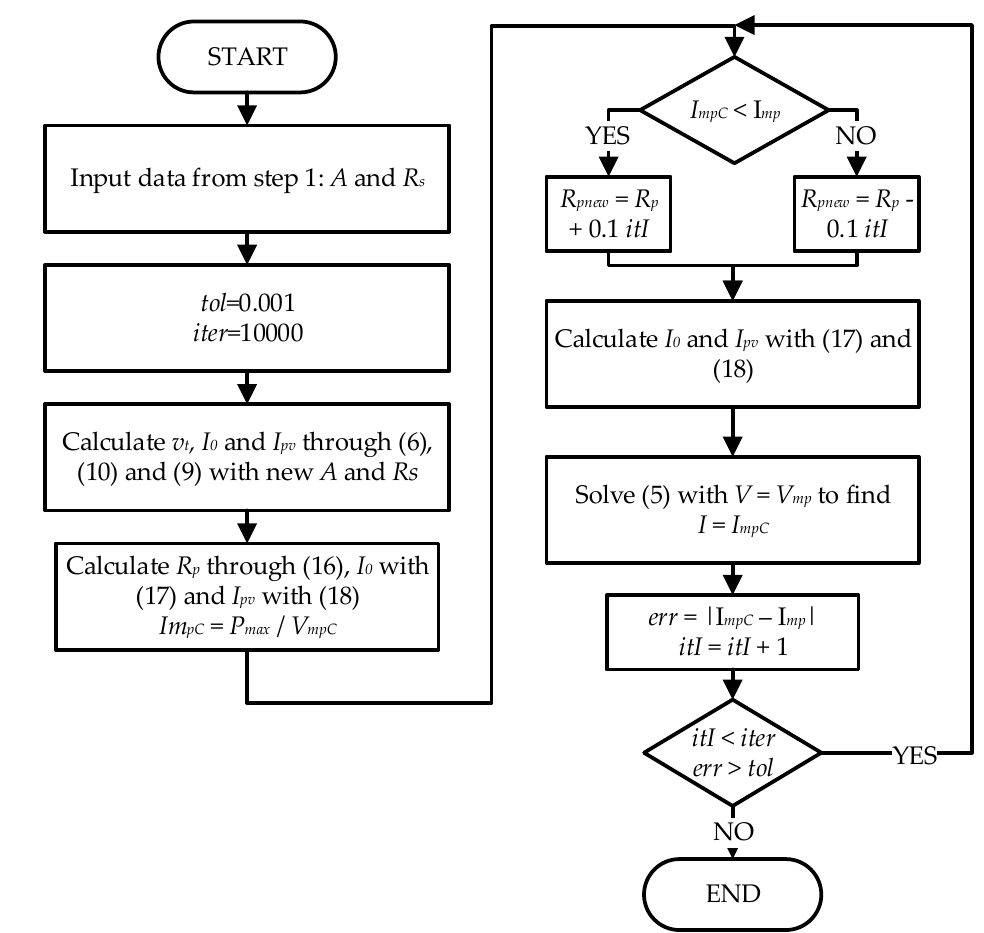
Figure 3. R p Calculation Algorithm (Step 2 of the proposed Method).